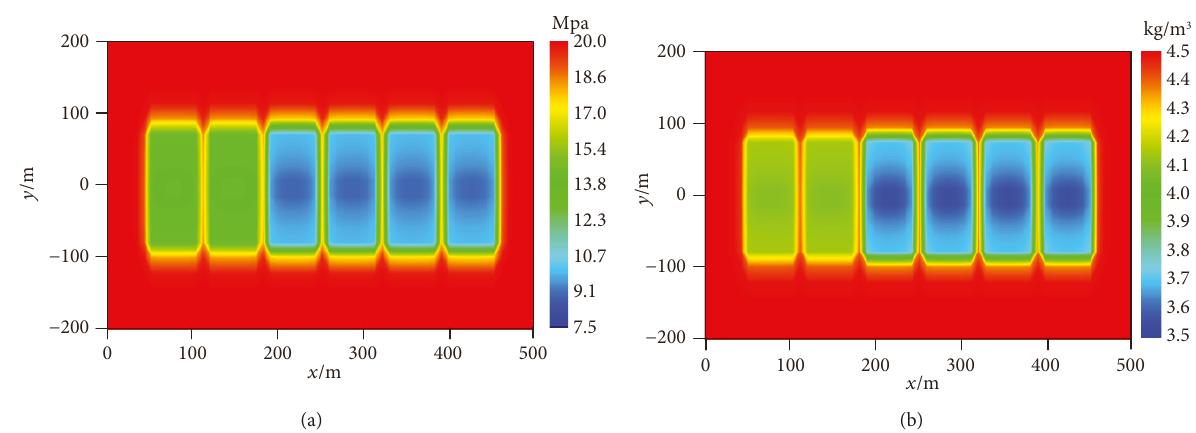
Figure 2: Reservoir pressure and reservoir adsorption gas content distribution after refracturing treatment.